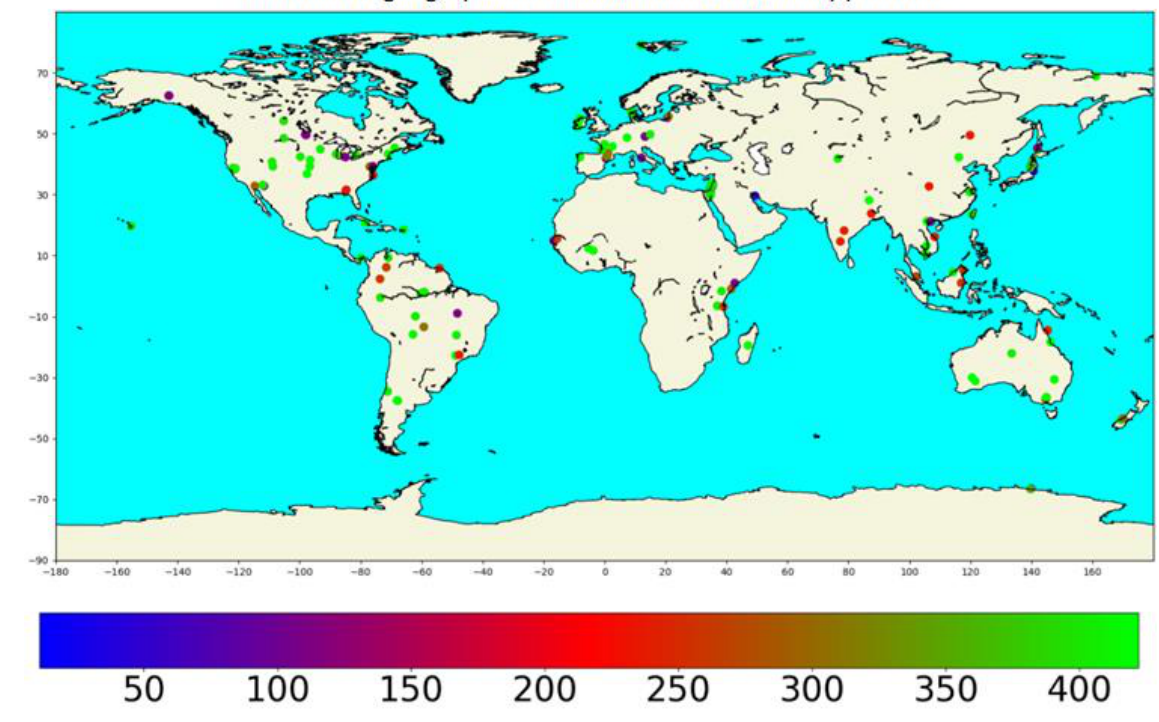
Figure 52. Number and geographic breakdown of raw inventory products.